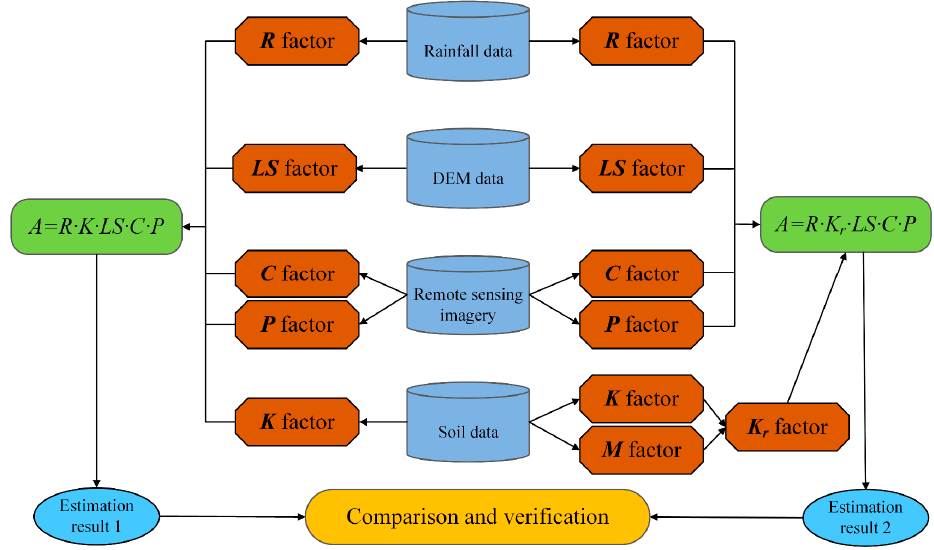
Figure 2. Flowchart depicting methodology of the study.